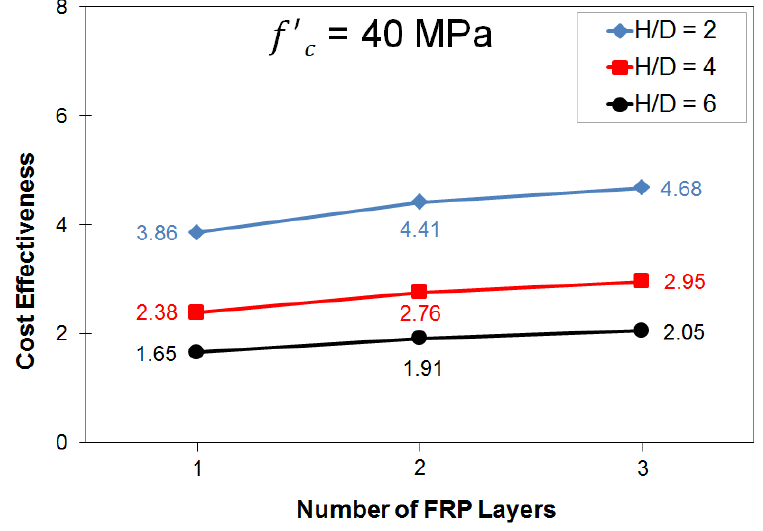
Figure 11. Cost effectiveness of SFRP confined concrete columns with 40 MPa concrete strengths and varying numbers of SFRP layers and slenderness